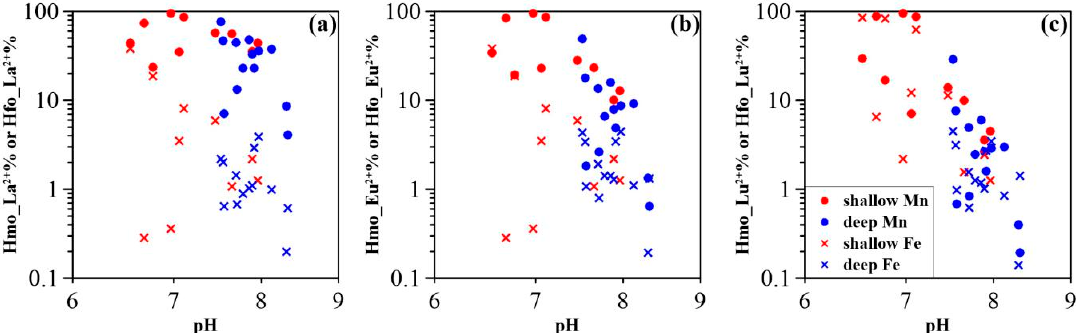
Figure 7. Proportion of ( a ) La, ( b ) Eu, and ( c ) Lu sorbed by HMO and HFO as a function pH (The sorbed La, Eu, and Lu were determined by modeling).